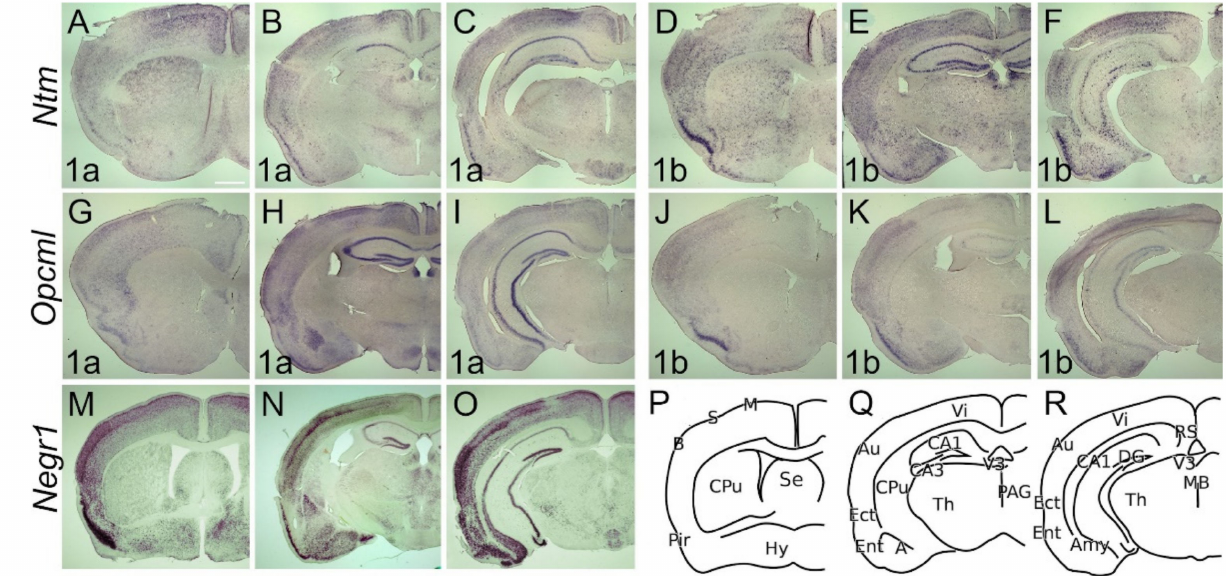
Figure 6. Expression from IgLON alternative promoters in the adult mouse CNS. In situ mRNA hybridization. ( A , D , G , J , M ) coronal sections through the level of olfactory tuberculum and septum. ( B , E , H , K , N ) sections through the middle part of Amy and diencephalon region. ( C , F , I , L , O ) caudal sections illustrate the mammillary hypothalamic region. (A) Ntm 1a expression is seen in Pir and anterior nuclei of thalamusas well as defined layers of sensory and motor cortex. ( B , C ) Observable Ntm 1a expression pattern is seen in visual and auditory cortex and ecto- and entorhinal cortices. Relatively strong expression is seen in amygdala as well as in specific cells of the hippocampus. ( D , E ) Similar expression pattern is seen with Ntm 1b probe, where strong expression is defined in the auditory cortex and amygdala. ( G , H ) Opcml 1a is broadly expressed in the cortex and strongest at upper layers throughout sensory and motor columns. Intense staining is seen in ( G ) piriform cortex and ( H , I ) hippocampus. Similarly ( J – L ) Opcml 1b is restricted to the upper layers of the sensory cortex. Strongest expression is seen in (J) piriform cortex. Faint expression is seen in ( K , L ) hippocampus. ( M , N ) Negr1 is broadly expressed in sensory cortical structures, notably in layers of the auditory cortex. Intense expression is seen in ( M ) piriform- and entorhinal cortex. ( N , O ) Relatively strong signal is seen in the hippocampus, notably in CA2 and dentate gyrus. Strong expression in amygdala greatly overlaps with other family members. Faint expression is observable in thalamic nuclei. ( P – R ) schemes of cutting planes. Abbreviations: 3V, third ventricle; Amy, amygdala; Au, auditory cortex; B, barrel cortex; CA1, cornuammonis region 1; CA3, cornuammonis region 3; CPu, caudal putamen; DG, dentate gyrus; Ect, entorhinal cortex; Ent, entorhinal cortex; LV, lateral ventricle; MS, medial septum; Ncx, neocortex; Pir, piriform cortex; Th, thalamus; Hy, hypothalamus. Scale bar: 1